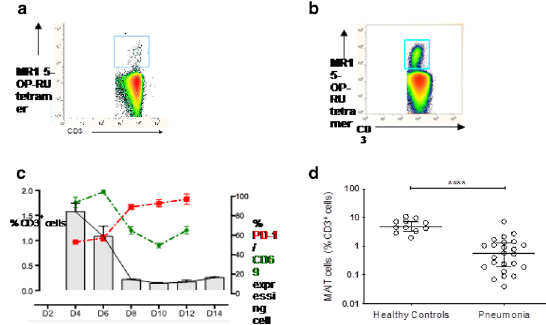
Fig. 1 Representative flow‑cytometry dot‑plots of MAIT cells labelling using fluorophore‑conjugated MR1 tetramers loaded with 5‑OP‑RU from lungs of an infected mouse (A) and blood sample of a patient with pneumonia (B). C: frequency of MAIT cells, proportion of CD69 and PD‑1 MAIT cells in bronchoalveolar lavage during experimental murine + pneumonia. D: blood frequency of MAIT cells in patients with pneumonia compared with healthy controls (as % of total T